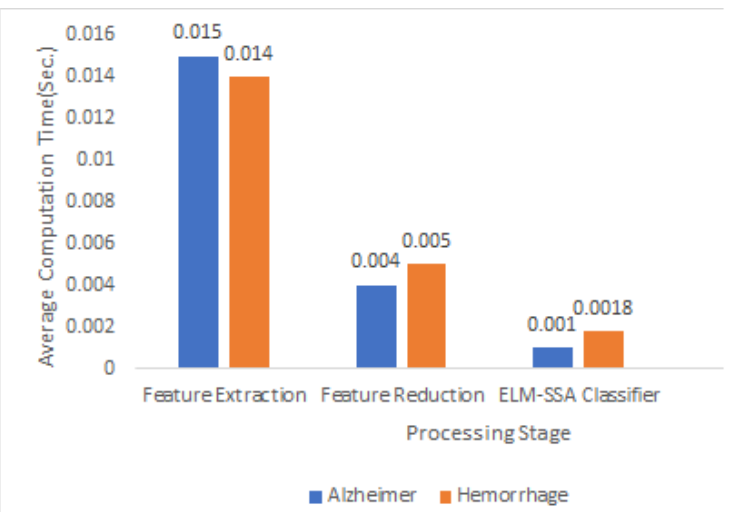
Figure 15. Average computational time in (second) at different phases of ELM-SSA over Alzheimer’s and Hemorrhage